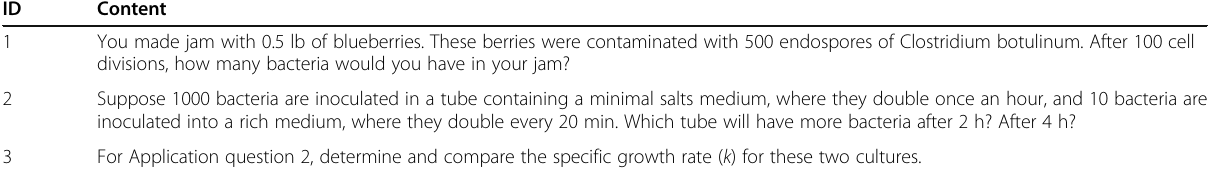
Table 4 The application questions presented to students during Miguel ’ s